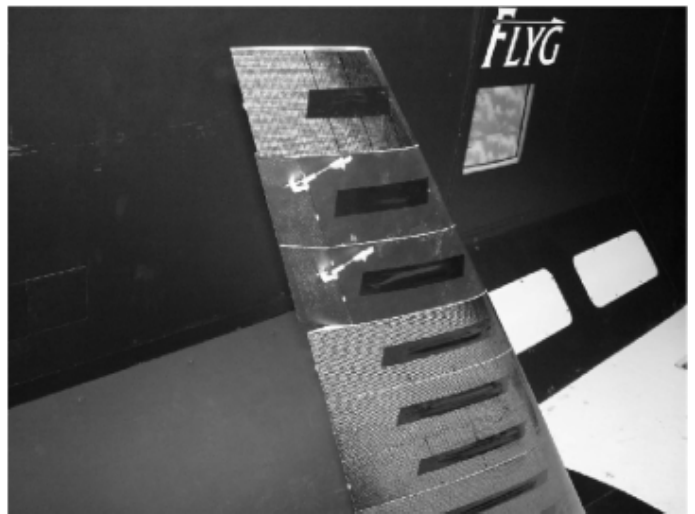
Figure 5. Single beam of wind tunnel model, Adapt with permission from [48].